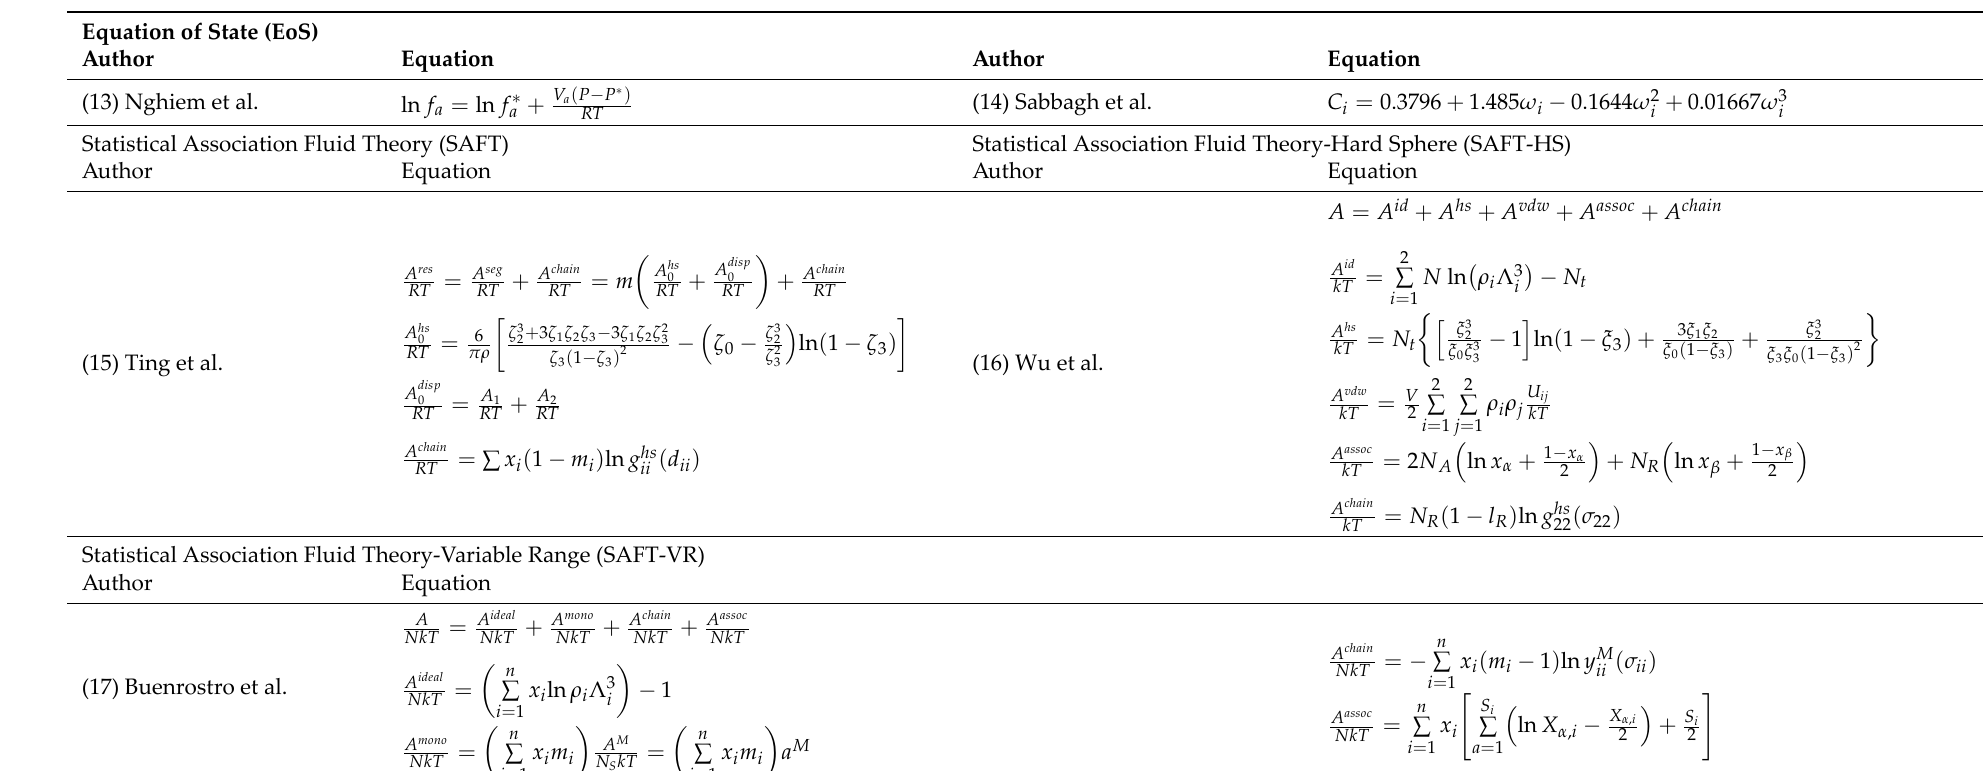
Table 2. Models to calculate asphaltene precipitation based on solubility approach (EoS, SAFT, SAFT‑HS, and